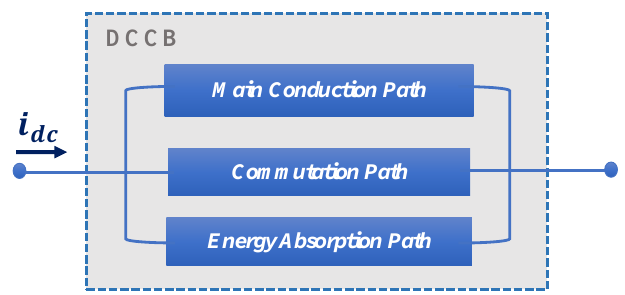
Fig.10 Generic DCCB layout [77] .